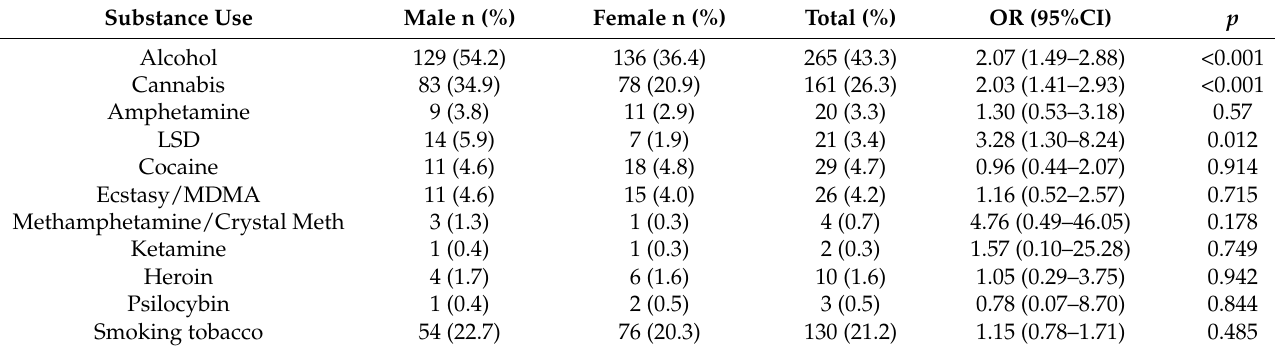
Table 5. Substance use.